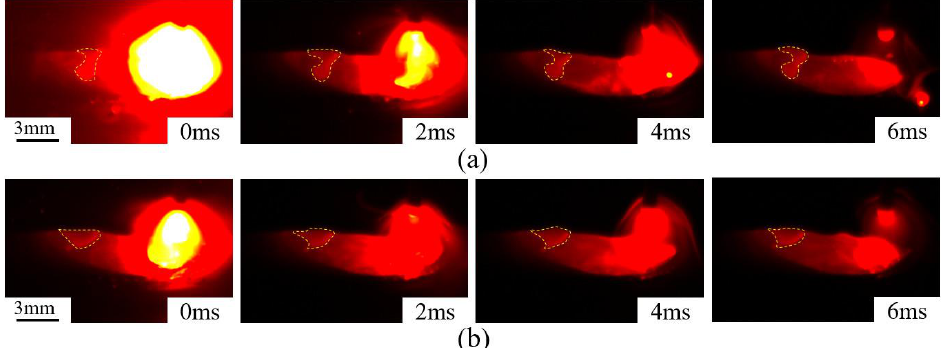
Figure 18. Effect of pulse waveform shape on the flow process of the welding pool and the morphology of molten slag in P-GMAW process: ( a ) exponential pulse waveform; ( b ) trapezoid pulse waveform.